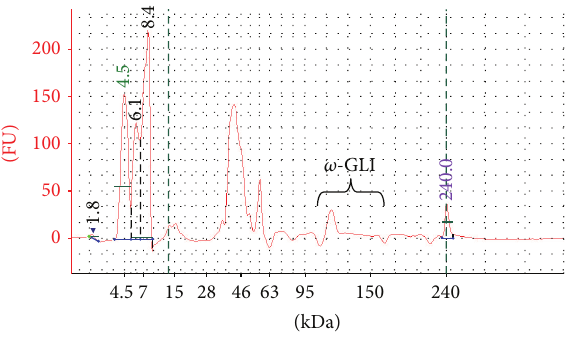
Figure 3: Electrophoregram of gliadins of cultivar “Aida.”